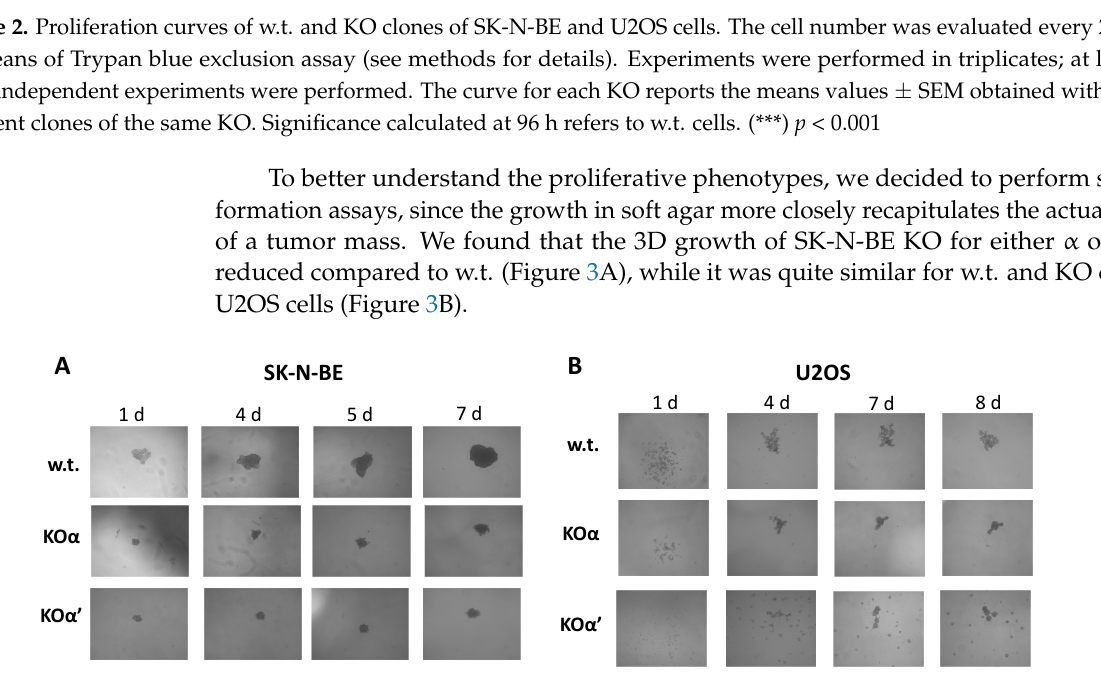
Figure 3. Spheroid formation potential of w.t. and KO clones of ( A ) SK-N-BE cells, and ( B ) U2OS cells were seeded in a 96-well plate precoated with 50 µ L of 1% agar (see Section 2). Inverted microscope images taken at the indicated times (d = days) are shown. At least two separate experiments were performed, in quadruplicates. Representative images (SK-N-BE KO α clone 1, KO α ’ clone 1; U2OS KO α clone 2, KO α ’ clone 1) are